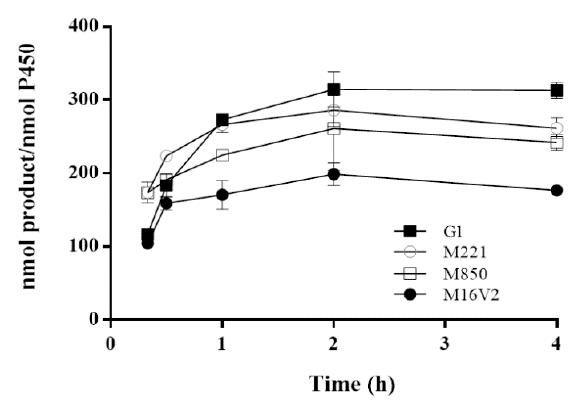
Figure 8. TTNs of naringin DC hydroxylation by CYP102A1 mutants. The reactions contained 500 µM naringin DC substrate and 0.40 µM of M16V2, G1, M221, or M850 in a 100-mM potassium phosphate buffer (pH 7.4). NADPH-generating systems were added to initiate the reaction, and the reaction mixtures were incubated for 20 min, 30 min, 1 h, 2 h, and 4 h at 37 °C.